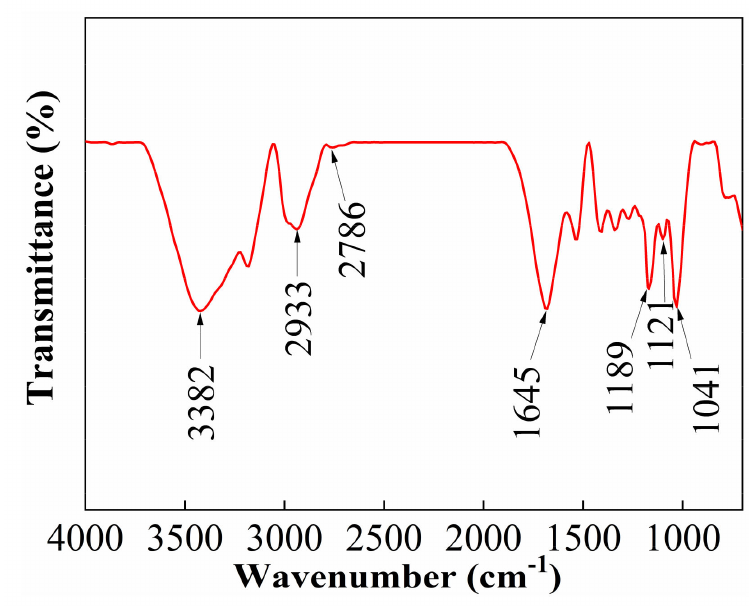
Figure 1. The FT-IR spectrum of